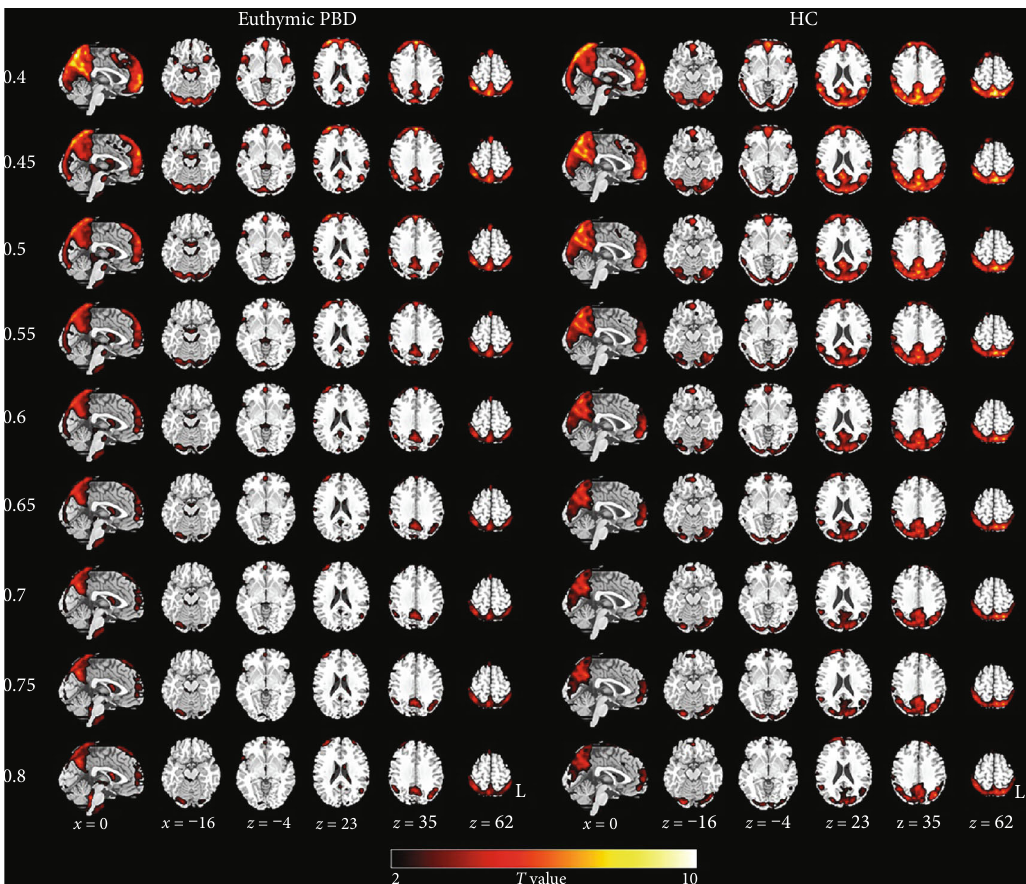
Figure 1: The global FCD maps for the nine Tc thresholds in the euthymic pediatric bipolar disorder (PBD) and healthy controls (HC) groups (one-sample t -test, P < 0 : 05 , FDR corrected, cluster size > 621 mm 3 ). L: left; R: right.